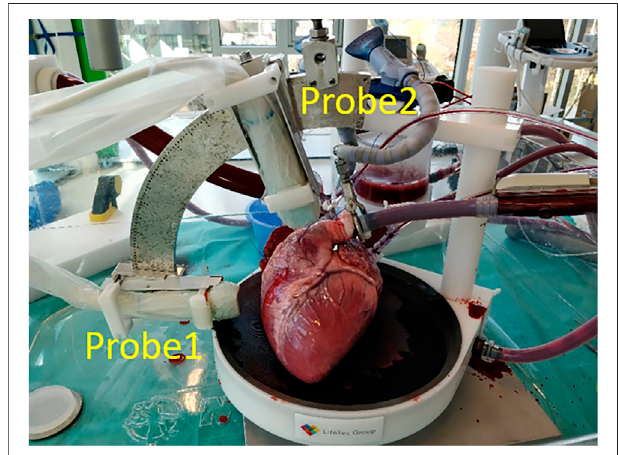
FIGURE 1 | Experimental setup of the beating porcine